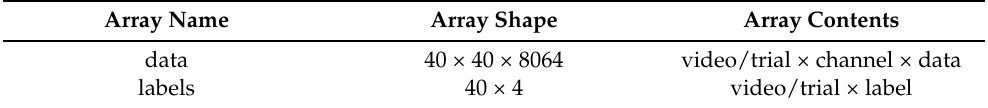
Table 1. The structure of